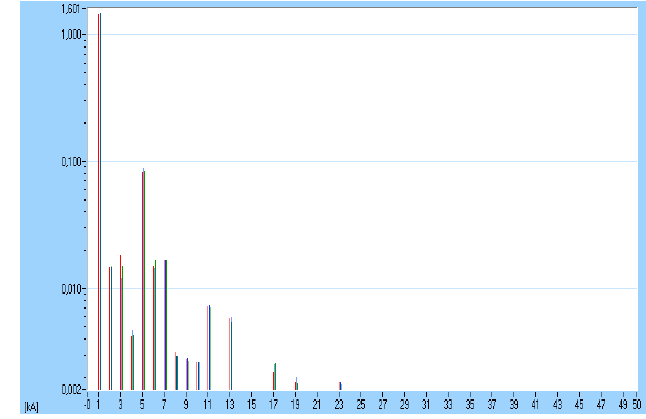
Fig. 10. Spectrum of harmonic current of higher levels with designated permitted limits in accordance with CSN EN 50160 – BS